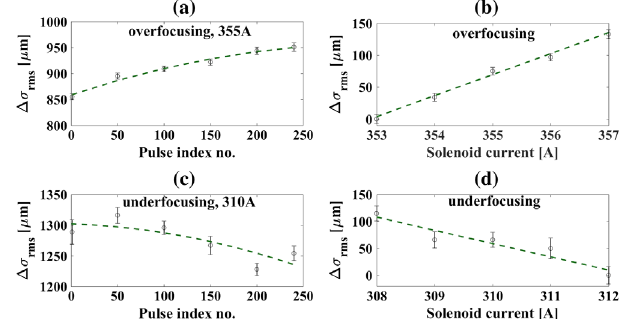
FIG. 14. Measured RMS bunch size and size change along a 240 μ s train for both the over- and underfocusing case.